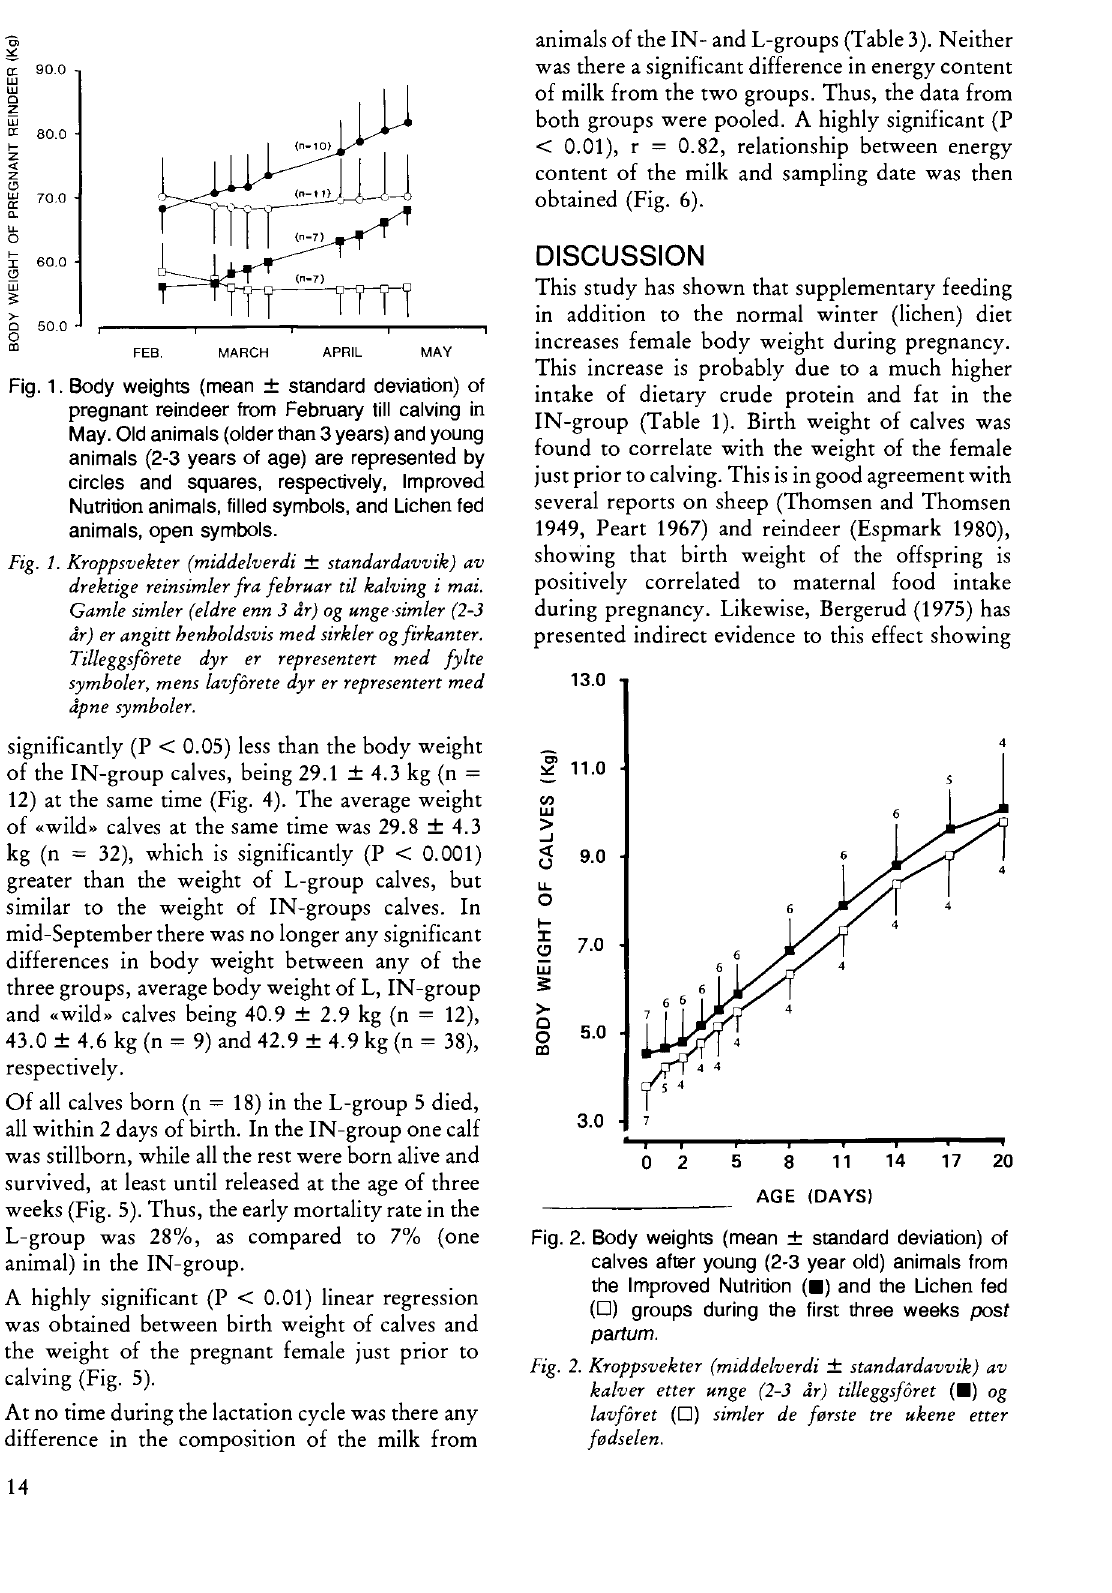
Fig. 2. Body weights (mean ± standard deviation) of calves after young (2-3 year old) animals from the Improved Nutrition (•) and the Lichen fed (•) groups during the first three weeks post partum. Fig. 2. Kroppsvekter (middelverdi ± standardavvik) av kalver etter unge (2-3 år) tilleggsfdret (•) og lavforet (•) simler de første tre ukene etter